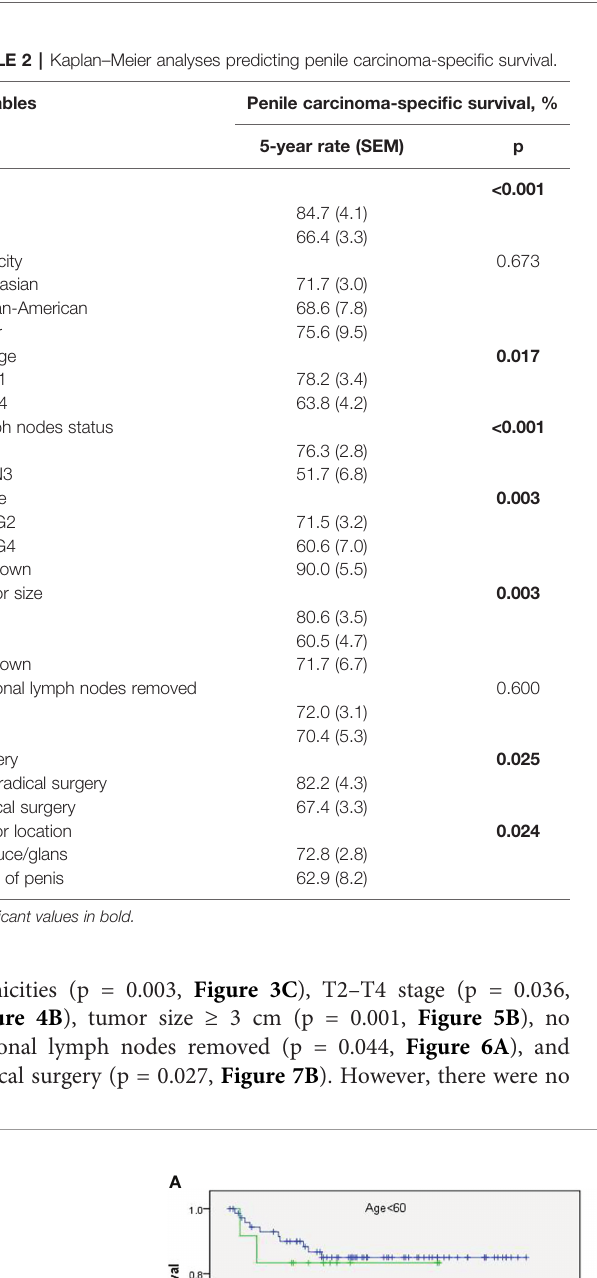
TABLE 2 | Kaplan – Meier analyses predicting penile carcinoma-speci fi c survival. Variables